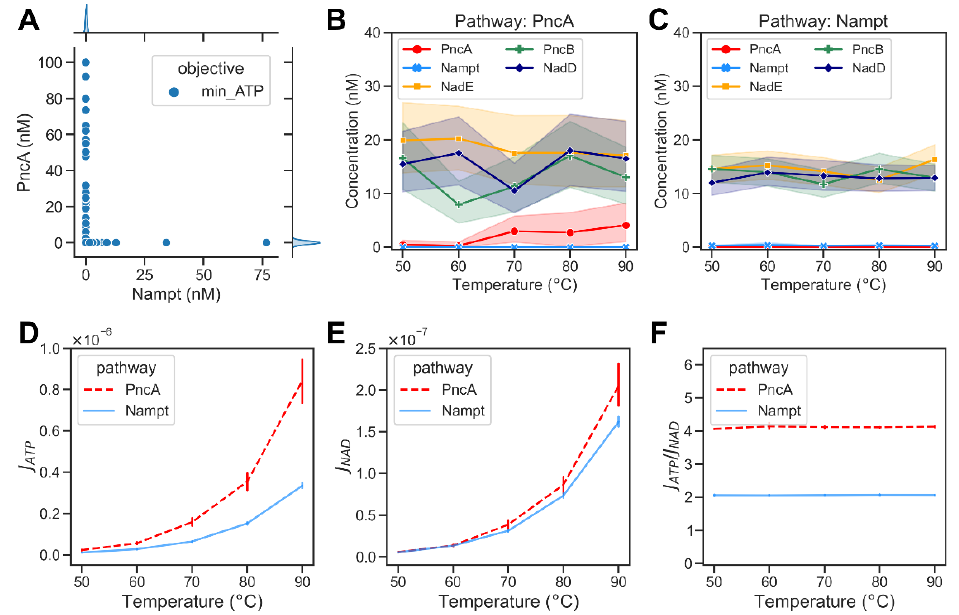
Figure 5. Optimization results of minimizing the total flux of ATP-consuming reactions of bacterial NAD biosynthetic pathways. ( A ) A scatter plot showing the abundances of Nampt versus PncA when minimizing the ATP consumption required to maintain the required NAD steady-state concentration (0.1 mM < C NAD < 0.3 mM ). Each dot represents an optimisation result. The marginal plots show kernel density estimate plots that show the enzyme abundance distributions in the optimisation results. ( B ) Optimized abundance of enzymes at different temperatures in PncA pathway. ( C ) Optimized abundance of enzymes from Nampt pathway. ( D ) The ATP consumption flux, J ATP , in PncA (dashed red curve) and Nampt (blue curve) pathways at different temperatures. ( E ) Computed NAD production flux, J NAD , in PncA and Nampt pathways at different temperatures. ( F ) Calculated ratio of ATP consumption flux to NAD production flux at different temperatures in PncA and Nampt pathways.